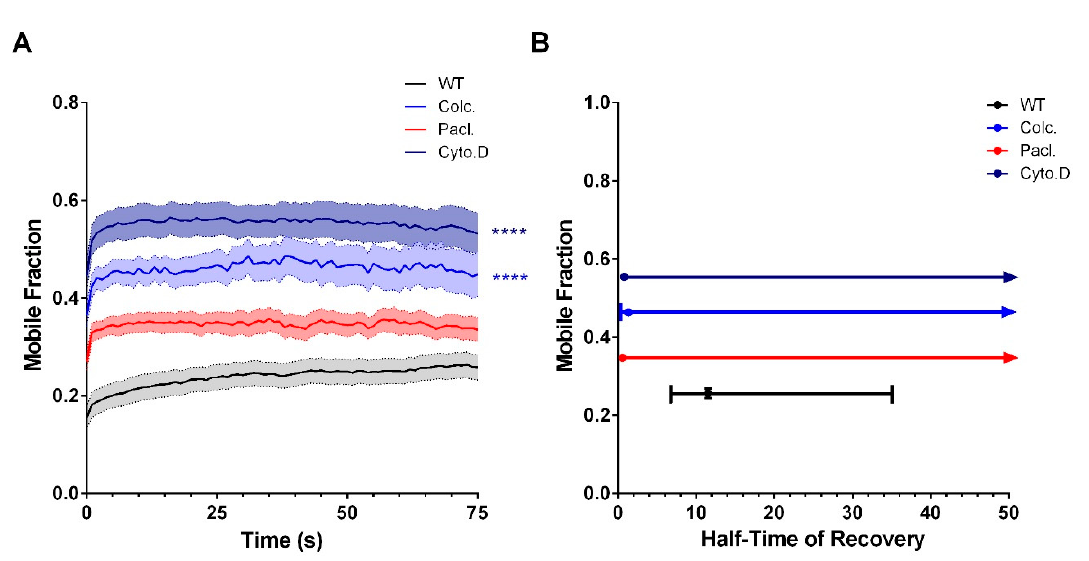
Figure 7. Cytoskeletal manipulation alters Cx36 delivery at the GJP. Recovery of fluorescence curves ( A ) and corresponding plots for M f against T 1 / 2 ( B ) demonstrated the relationship between the mobile fraction and half-time of recovery. The M f and T 1 / 2 under Colchicine (Colc) and Paclitaxel (Pacl) treatment demonstrated a significant reduction. While the T 1 / 2 remained lower than the untreated wild-type, inhibition of the actin cytoskeleton with Cytochalasin D (CytoD) resulted in an increase in the mobile fraction, indicating that GJPs became more fluid and suggesting that actin may play a role in fine-tuning Cx36 incorporation at the GJP. Recovery curves are the mean ± SEM and mean ± CI for the XY plots of mobile fraction against half-time of recovery. Sample sizes ( n ) were n = 28 for the WT, n = 26 for Colchicine, n = 24 for Paclitaxel, and n = 22 for Cytochalasin D treated GJPs. **** p < 0.0001, Kruskal–Wallis test; all samples were compared to the wild-type control.